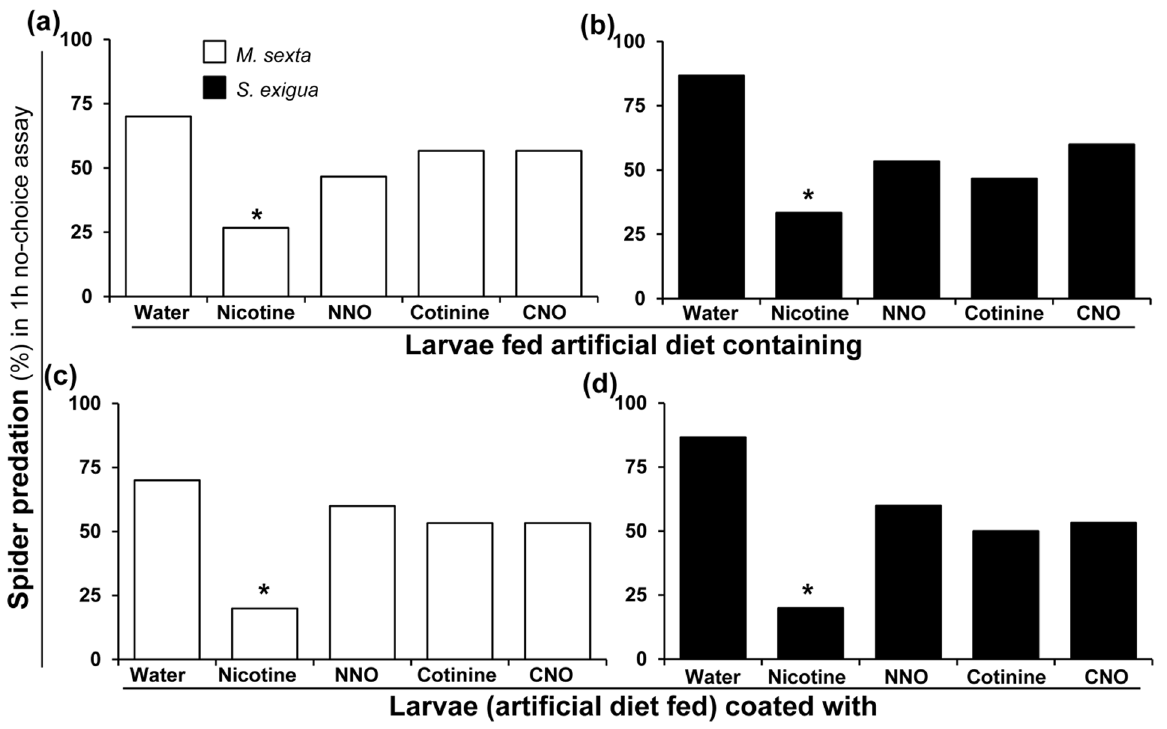
Figure 7. Nicotine deters C.parallela but nicotine oxides do not. C. parallela ’s predation (%) (in 1 h no-choice assay) on second-instar ( a ) M. sexta and ( b ) S. exigua larvae fed artificial diet containing water (control) or 0.1% (fresh mass) nicotine, NNO, cotinine or CNO. C. parallela predation (%) (in 1 h no-choice assay) on second-instar artificial diet fed ( c ) M. sexta and ( d ) S. exigua larvae coated with water (control) or 0.2% aqueous nicotine, NNO, cotinine or CNO. Each bar represents data from 30 larvae. Asterisks indicate significant differences ( P # 0.05) in frequencies (and displayed percentages) by Fisher’s exact test.